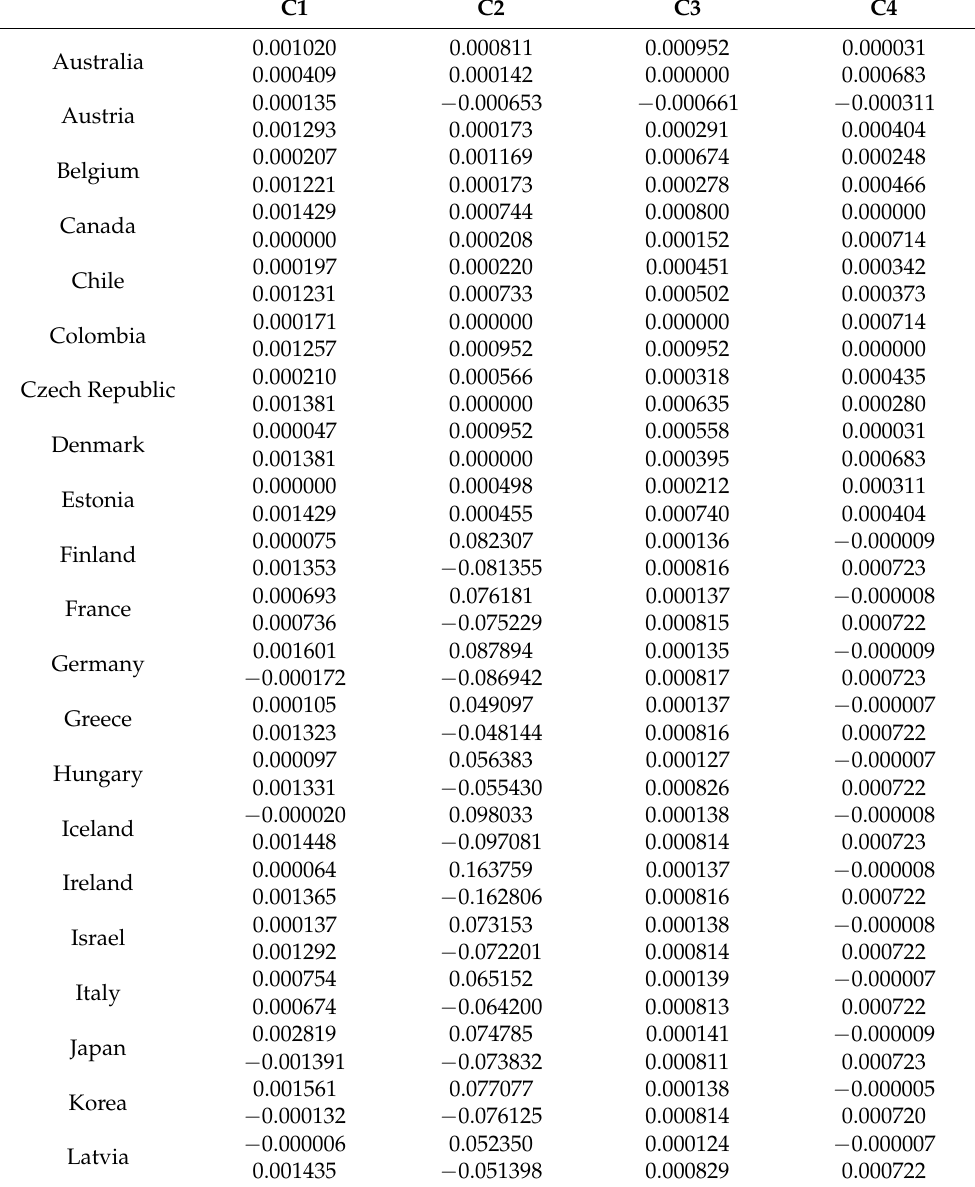
Table 4. The values of the Real Rating Matrix ( T r ) for the case study. Each numerical element was defined by means of the formulas (4) and (5) in Section